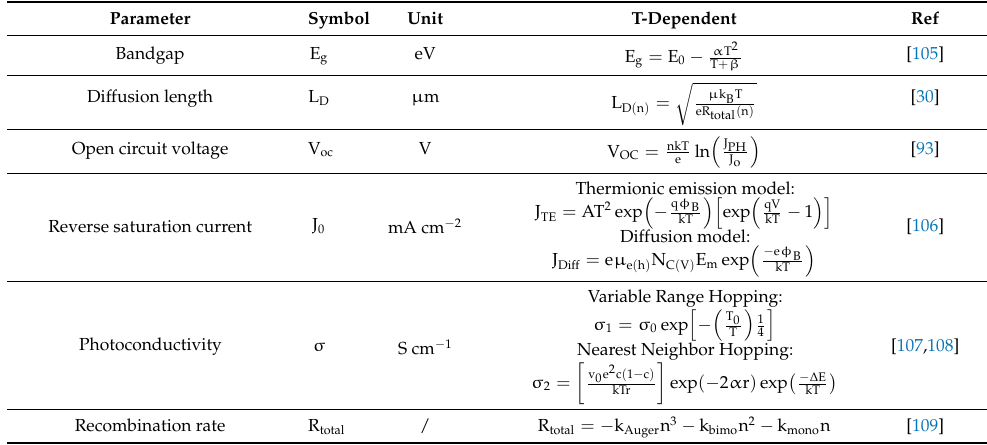
Table 1. Photoelectric parameters with certain temperature-dependent